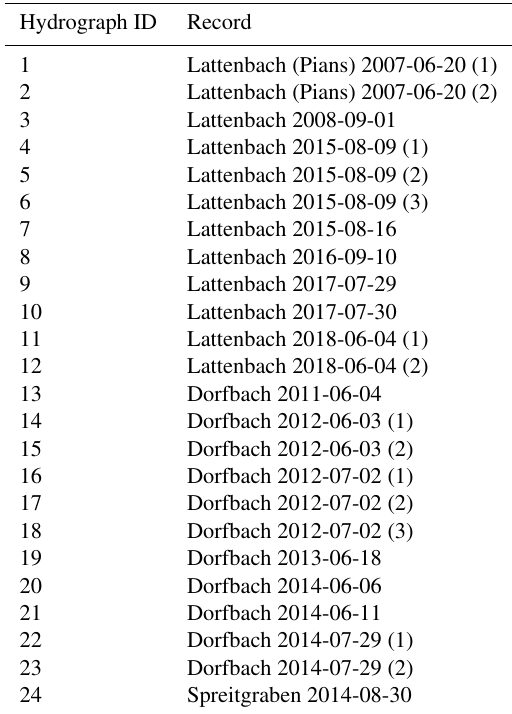
Table A1. Summary of inflow hydrograph IDs.